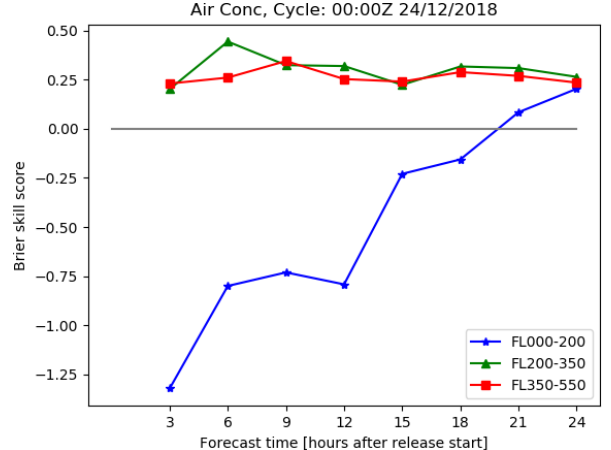
Figure 13. Brier skill score changes over time since the start of the eruption for a simulation with a low Brier score. This is for the same case as Fig.